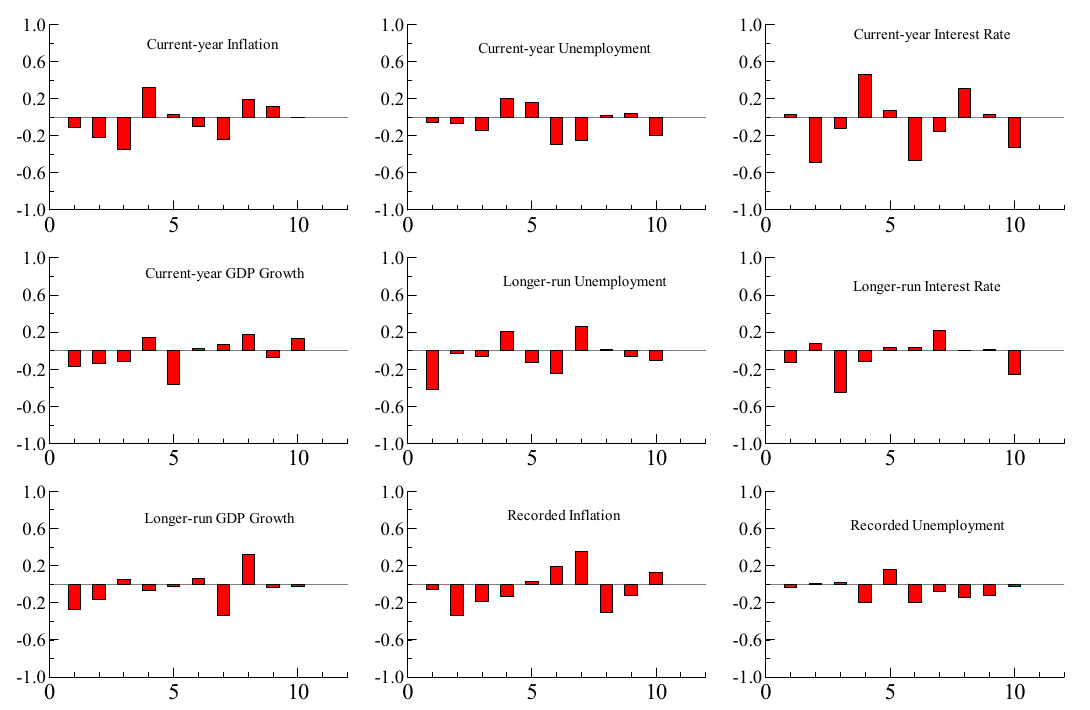
Figure A3. Autocorrelation coefficients for regression residuals.